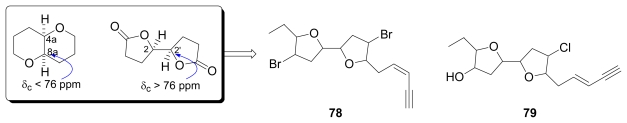
Proposed and reproposed structures of elatenyne.